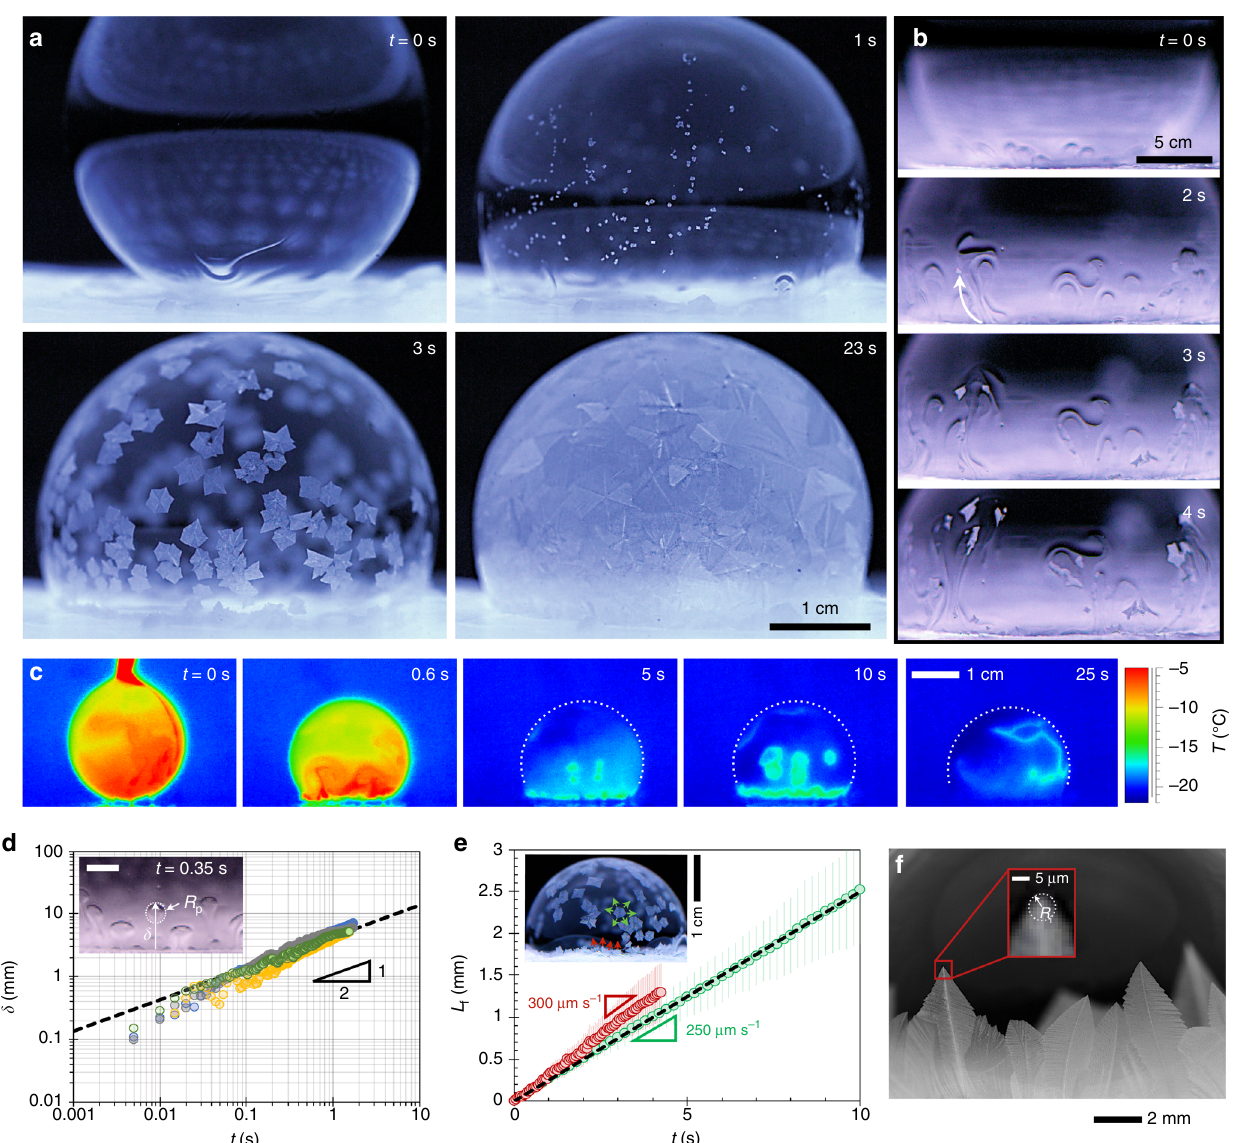
Fig. 2 Freezing bubbles under chilled and isothermal conditions. a Freezing of a 10-mL bubble deposited on an ice disk (Supplementary Fig. 3) in a